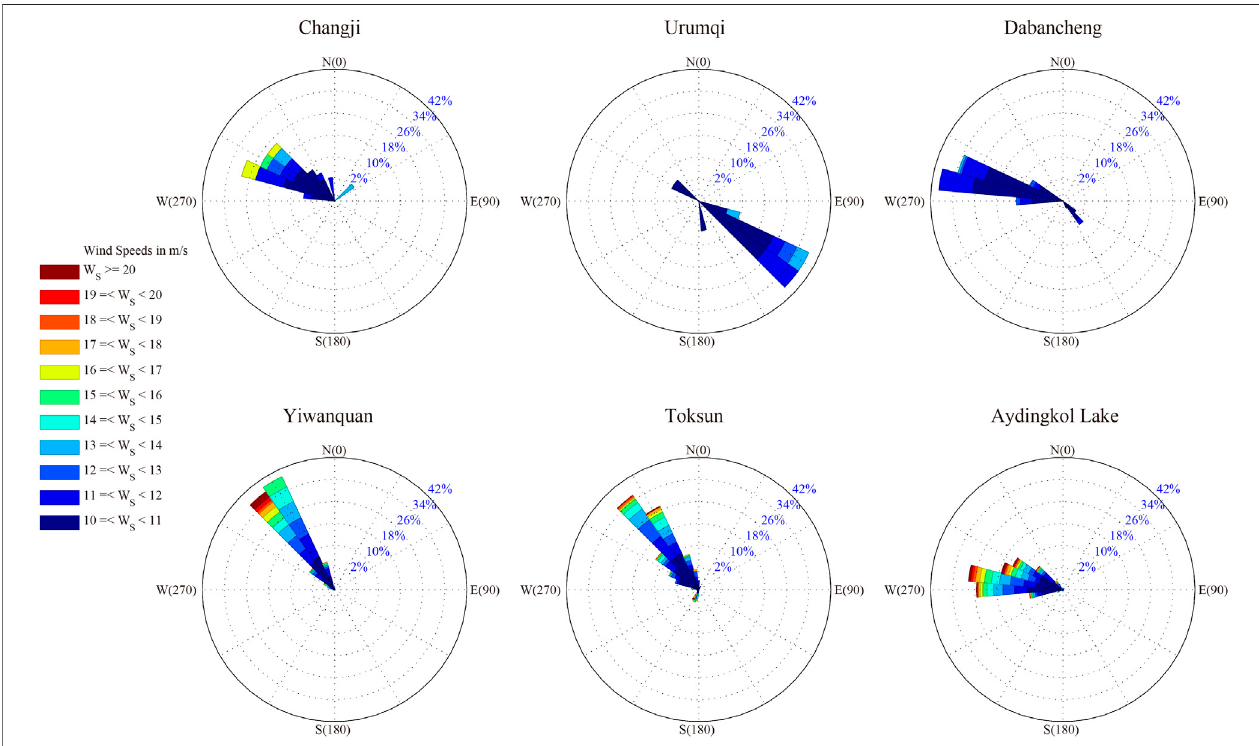
FIGURE 3 | Wind rose diagrams of high winds at the six automatic weather stations during 2017 – 2018.